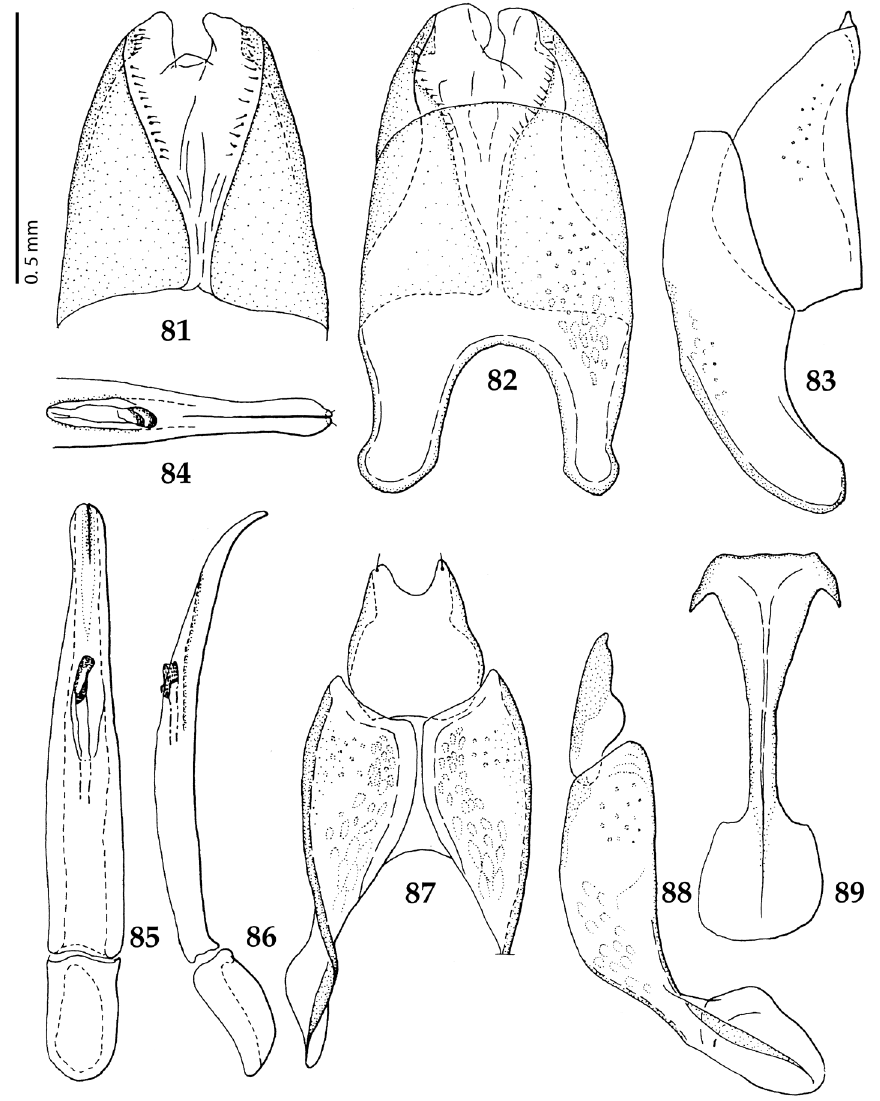
Figures 81–89. 81 Gnathoncus communis (Marseul, 1862) male terminalia after Ôhara (1994): 8 th sternite, ventral view 82 male terminalia: 8 th sternite + 8 th tergite, dorsal view 83 ditto, lateral view 84 male terminalia: apex of aedeagus, dorsal view 85 male terminalia: aedeagus, dorsal view 86 ditto, lateral view 87 male termi- nalia: 9 th + 10 th tergites, dorsal view 88 ditto, lateral view 89 male terminalia: spiculum gastrale, ventral view. Remarks. G. communis can be confused with G. rotundatus , but can easily be sepa- rated from it by the absence of median fossa of prosternum (present with G. rotundatus ), dense and confluent elytral punctation (especially in the apical half of the elytra)